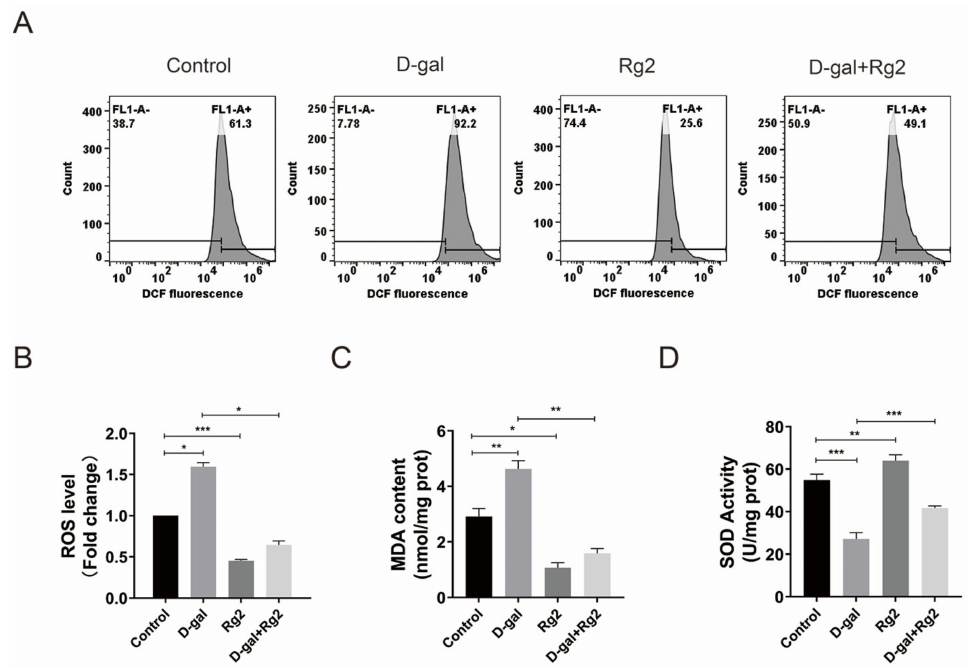
Figure 6. Ginsenoside Rg2 protected pMSCs against oxidative stress. After pre–incubation with 20 g/L of D–gal for 24 h, pMSCs were treated with 100 µ M of Rg2 in the presence/absence of D–gal for another 24 h. ( A ) Histograms of ROS levels in pMSCs after different treatments using flow cytometry. ( B ) Quantification of intracellular ROS levels in ( B ). ( C ) MDA contents in pMSCs after different treatments. ( D ) SOD activities in pMSCs after different treatments. * p < 0.05, ** p < 0.01, and *** p < 0.001; n =